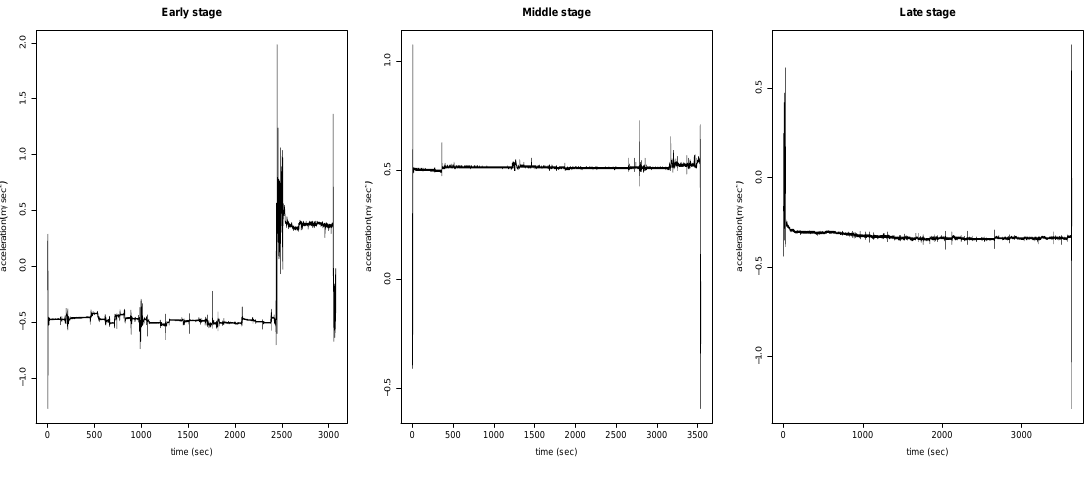
Figure 2. Measured acceleration on the x -axis for the accelerations of the patients in m/s 2 versus the time in s, at different stages of the disease: early ( left ), middle ( central ) and late ( right